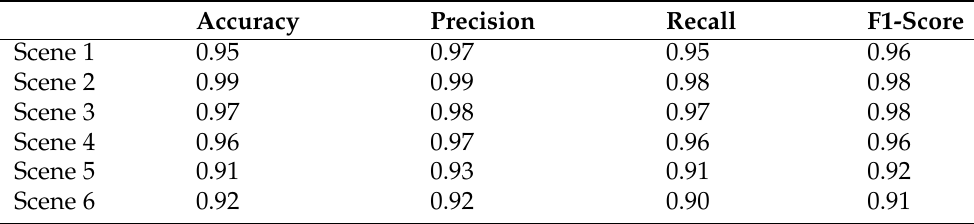
Table 5. Classification metrics from real-time case study evaluation for each scene.